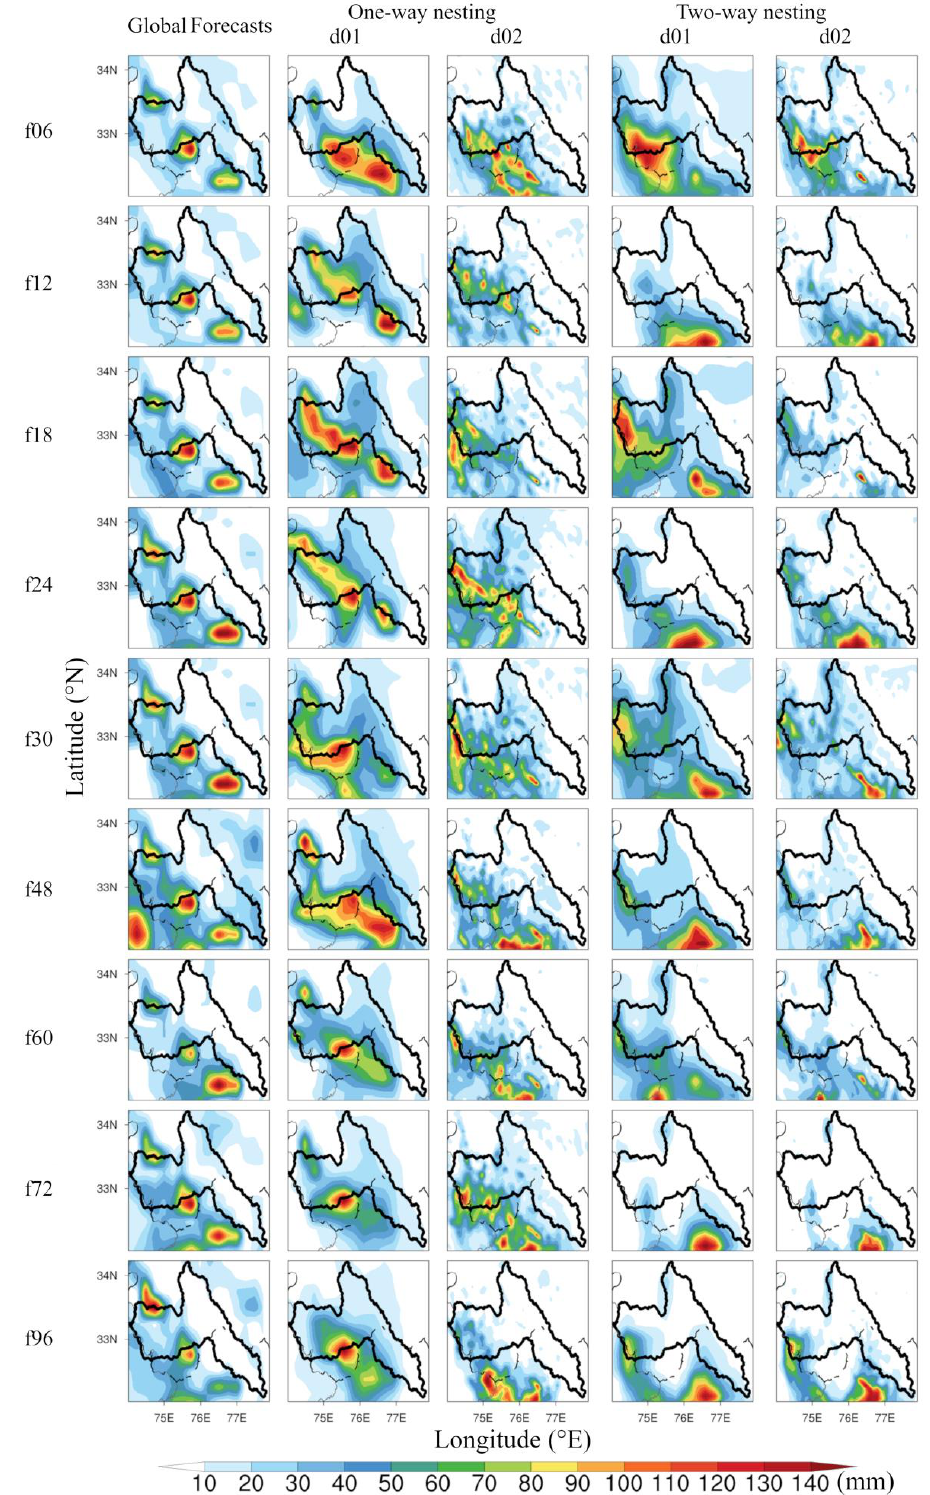
Figure 5. Spatial distribution of GFS and WRF downscaled accumulated precipitation (mm) from 00:00 UTC 06 August 2016 to 18:00 UTC 07 August 2016. The forecast lead times are shown on the left, and the experiment type is shown at the